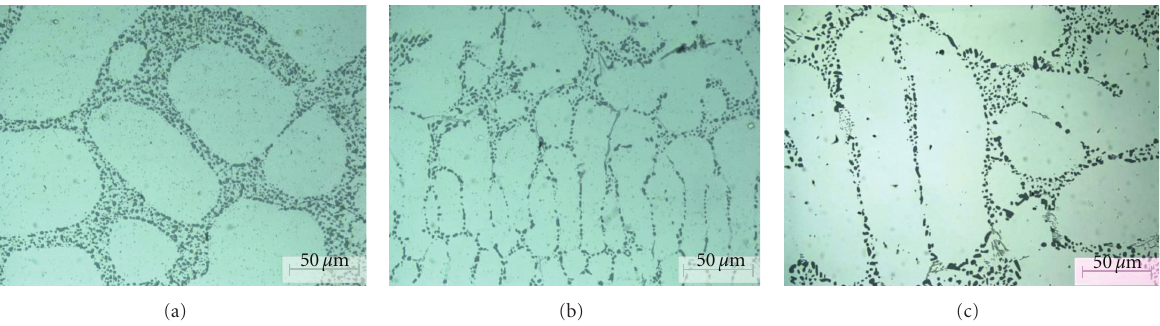
Figure 3: Optical micrographs of A356 in the T6 condition produced by (a) SSM-HPDC, (b) GDC, and (c) IC.